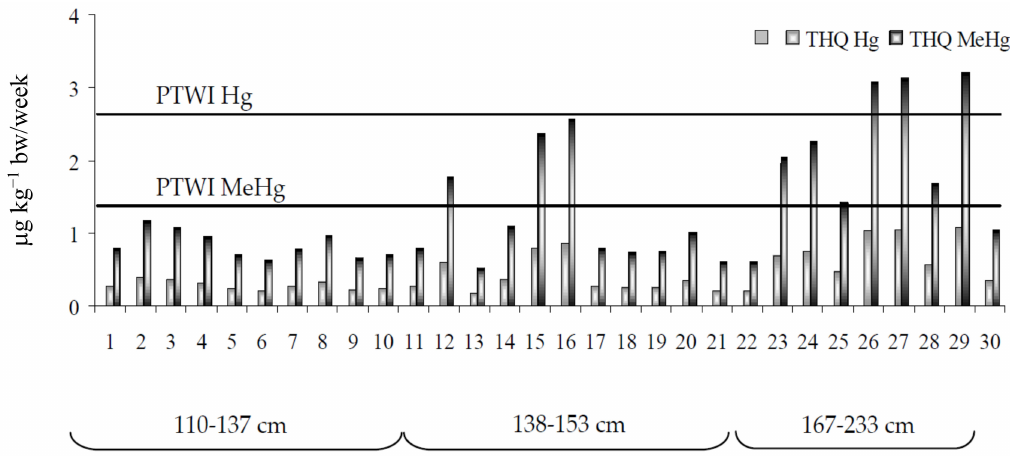
Figure 2. Provisional Tolerable Weekly Intake (PTWI) for Hg and MeHg and estimated weekly intake by consumption of different swordfish size